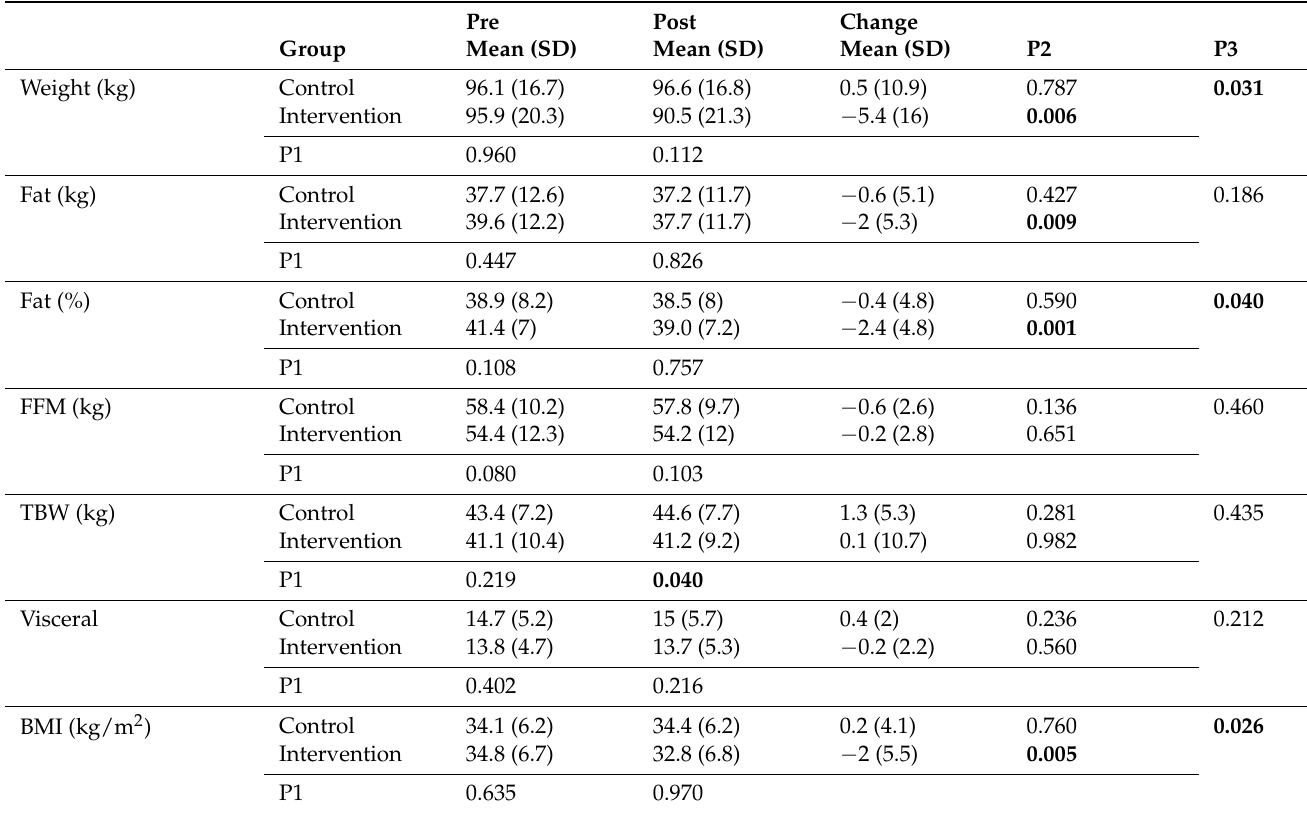
Table 5. Changes in anthropometric measurements after 3 months in control vs. intervention